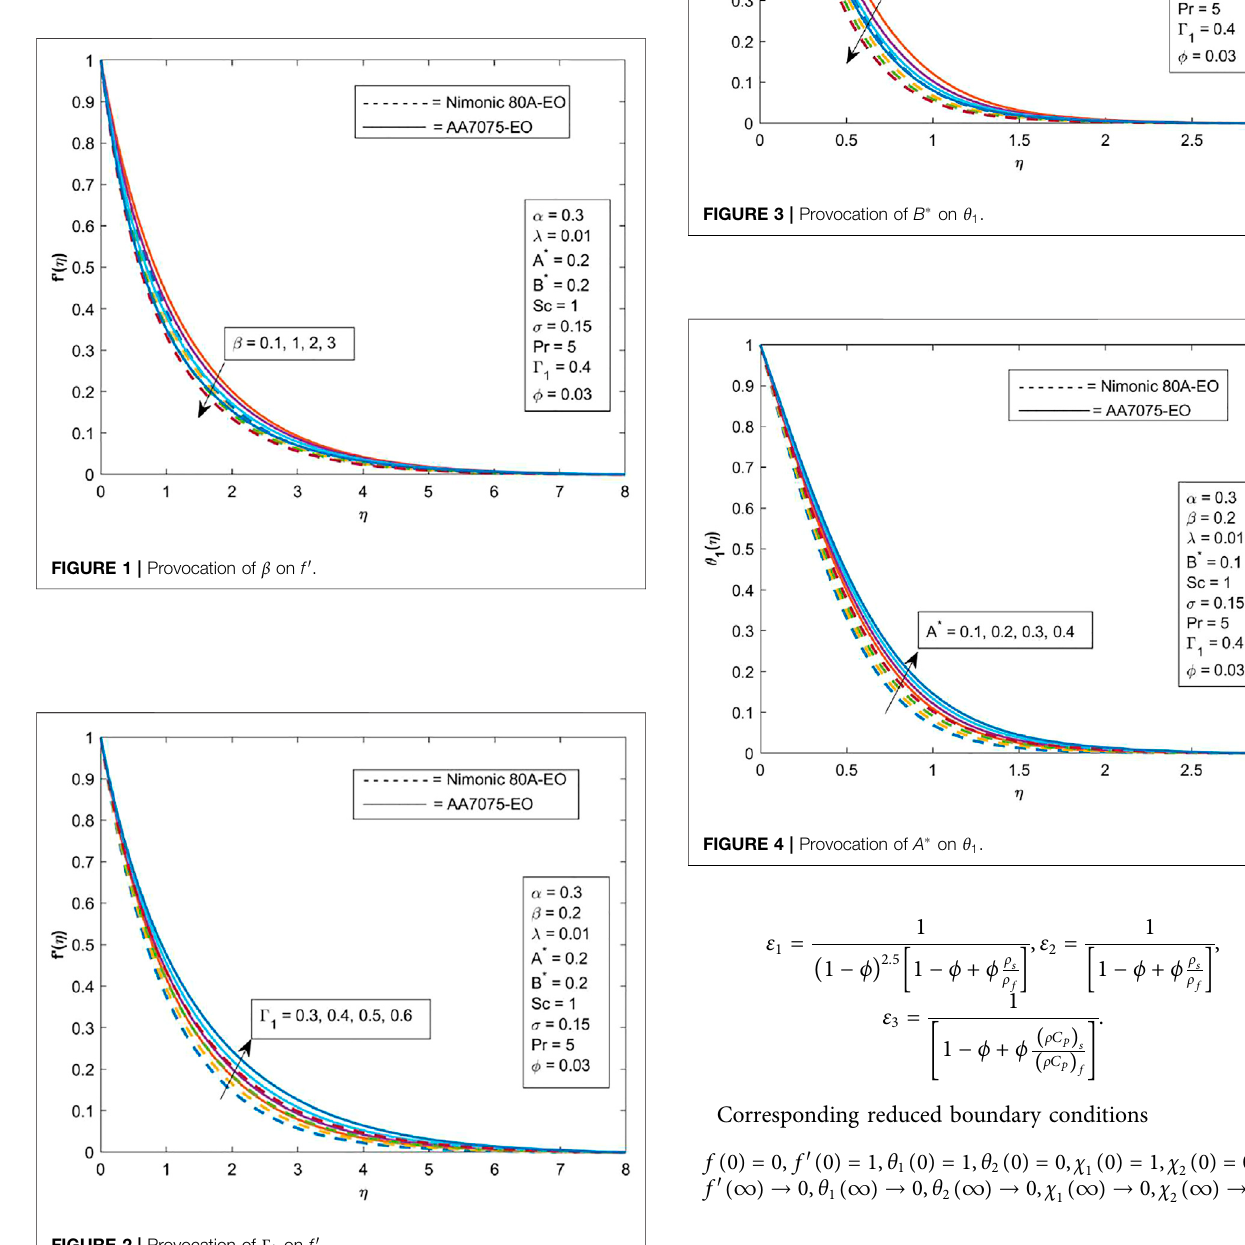
FIGURE 2 | Provocation of Γ 1 on f ′ .